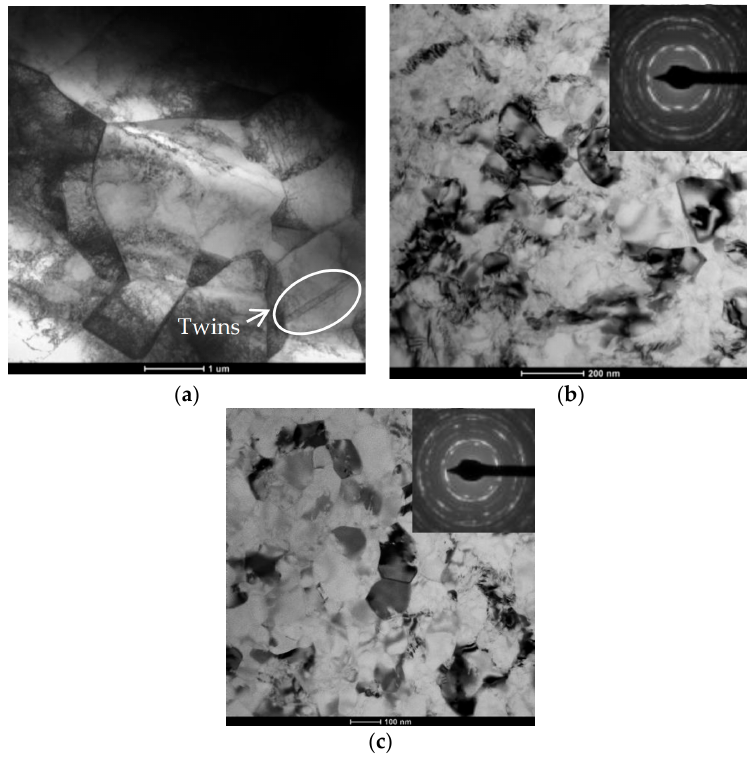
Figure 6. TEM micrographs and corresponding SAED patterns of cold rolled samples: ( a ) AS (As-received) + CR; ( b ) 4p-ECAP + CR; ( c ) 8p-ECAP + CR.